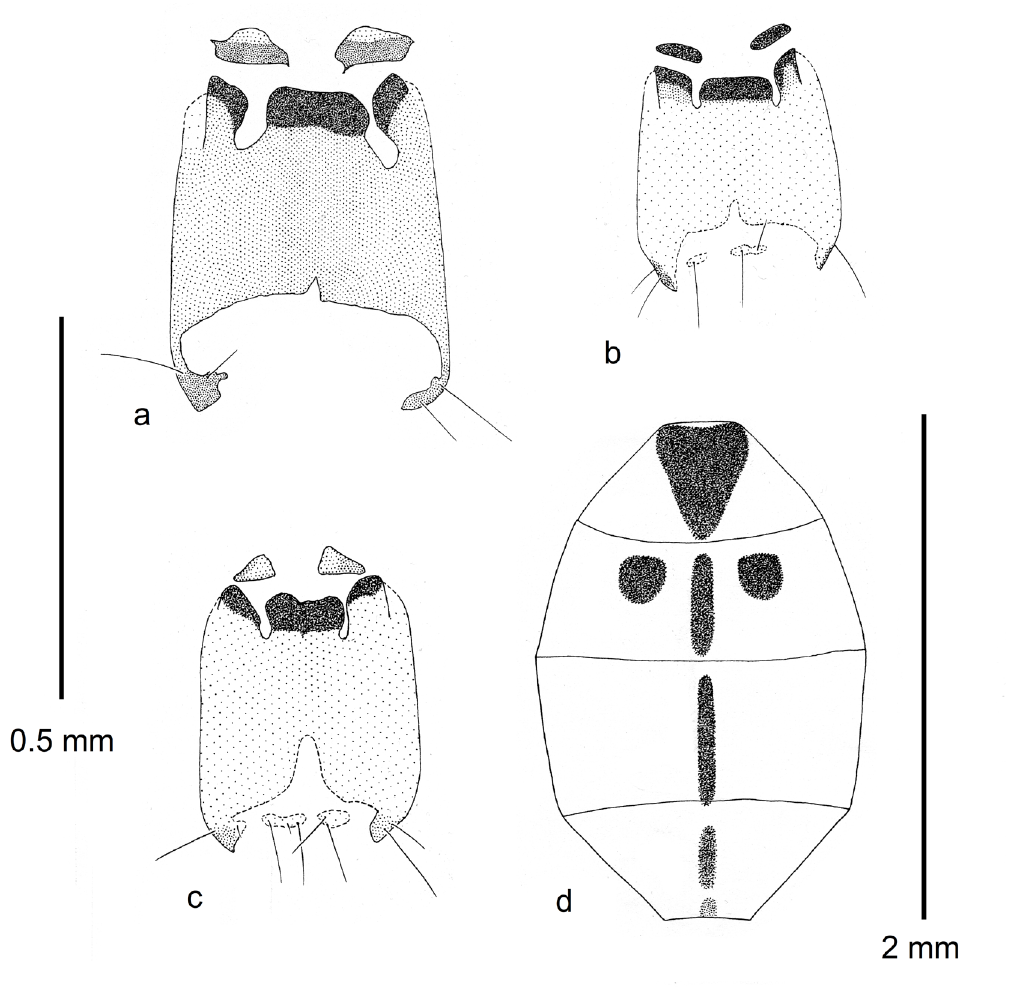
Fig. 1. a–c . Female eighth tergite, dorsal. a . Atherigona bifida Deeming, 1971. b . Atherigona contrastiloba Deeming, 1987. c . Atherigona nigrithorax Stein, 1906. d . Atherigona nigrithorax , preabdomen,